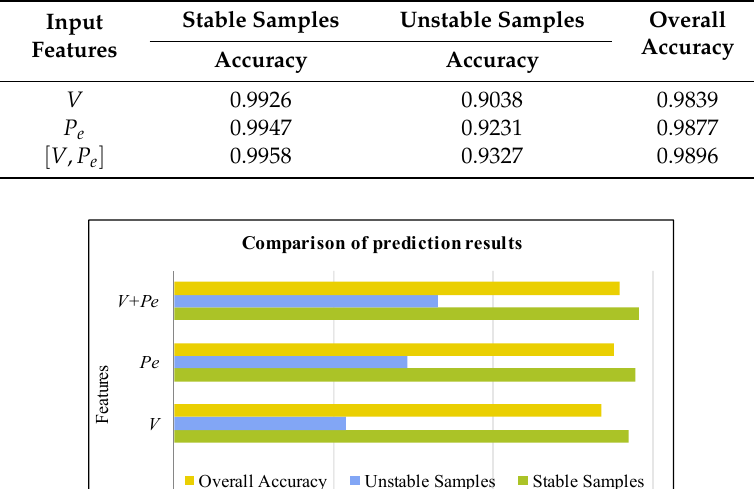
Table 5. Comparison of different sets of input features.